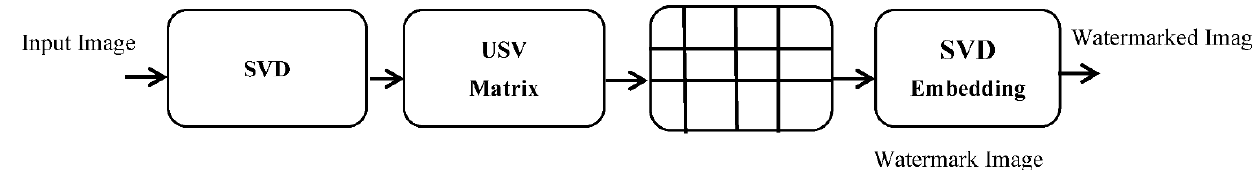
Figure 5. Block diagram of the SVD